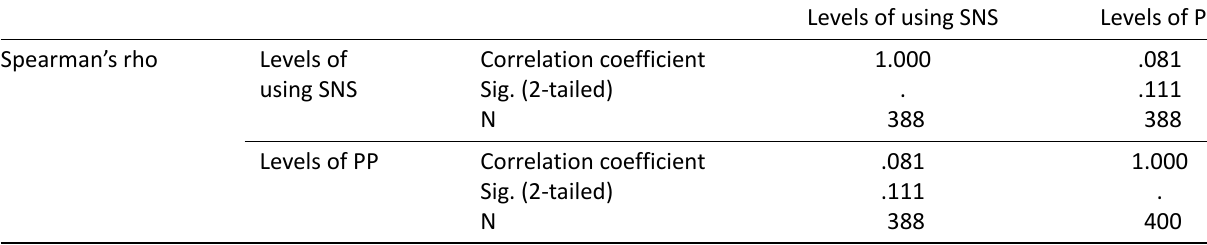
Levels of using SNS Levels of PP